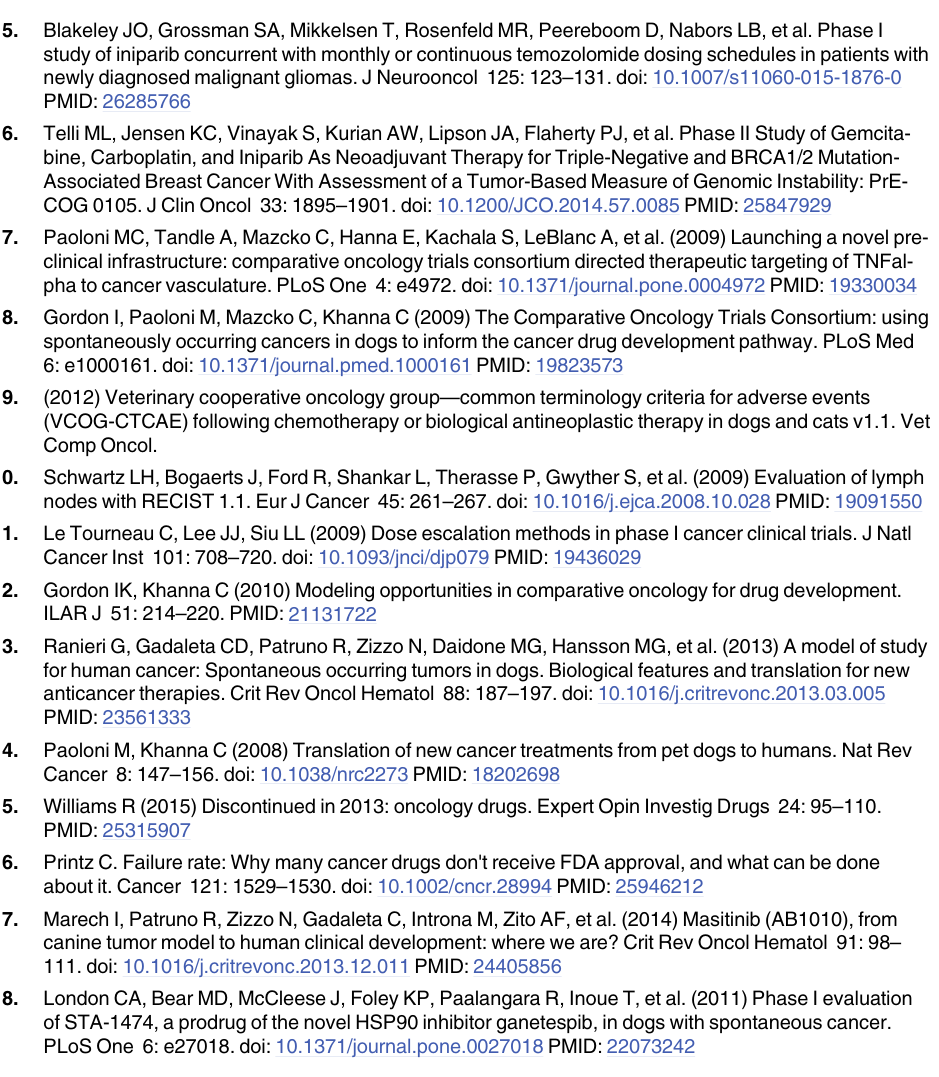
PLOS ONE | DOI:10.1371/journal.pone.0149194 February 11,